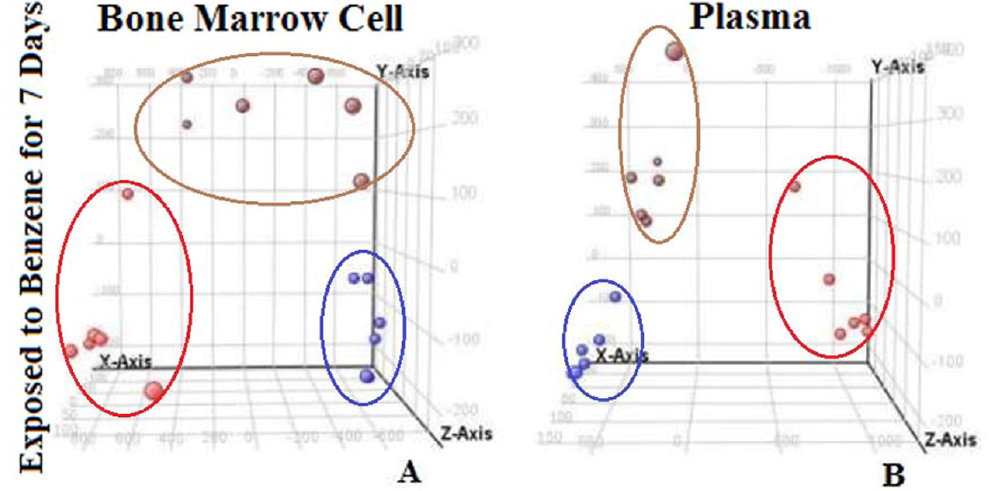
Figure 5. 3D PCA score plot of the metabolic profiles of bone marrow cells ( A ) and plasma ( B ) in the control group (red), benzene 1 group (brown), and benzene 2 group (blue) on exposure day